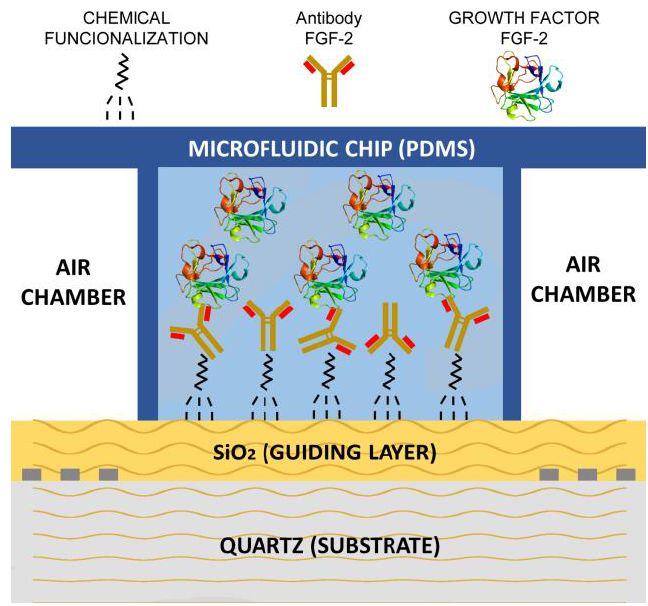
Figure 3. Schematic of the device sensing the growth factor FGF-2.